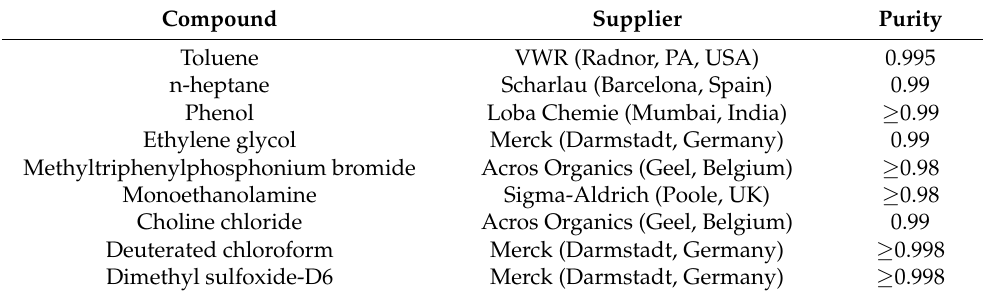
Table 1. List of chemicals used in this